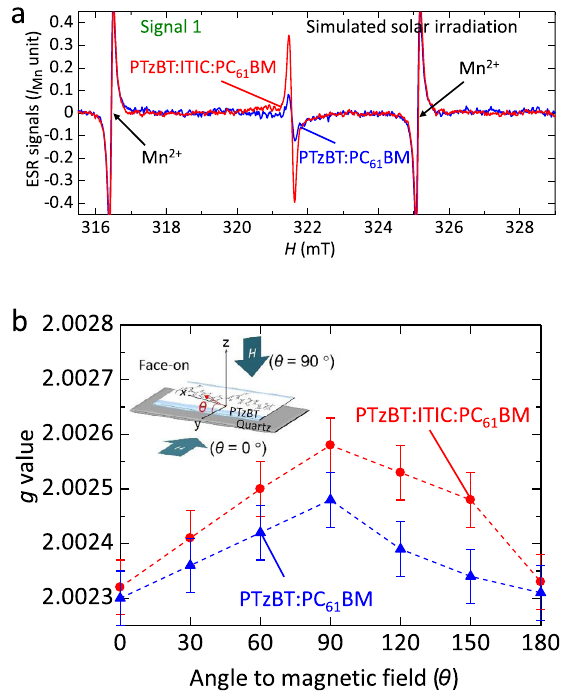
328-0.2 326 Fig. 3 ESR signals of thin fi lms of PTzBT:ITIC:PC 61 BM and PTzBT: PC 61 BM, and the anisotropy measurements. a ESR spectra of thin fi lms of PTzBT:ITIC:PC 61 BM (red line) and PTzBT:PC 61 BM (blue line) (de fi ned as Signal 1) after 20 h solar irradiation. b Anisotropies of the ESR signals of the PTzBT:ITIC:PC 61 BM and PTzBT:PC 61 BM thin fi lms measured by changing the angle θ between the substrate plane and H direction. The error bars are Fig. 2 Operando ESR signals of PTzBT cells with and without ITIC. a – d Time variation of operando ESR spectra of PTzBT cells ( a , c ) with and ( b , d ) without ITIC under solar irradiation under ( a , b ) short- and ( c , d ) open-circuit conditions at room temperature, respectively. The substrate planes are parallel to the direction of external magnetic fi eld H .